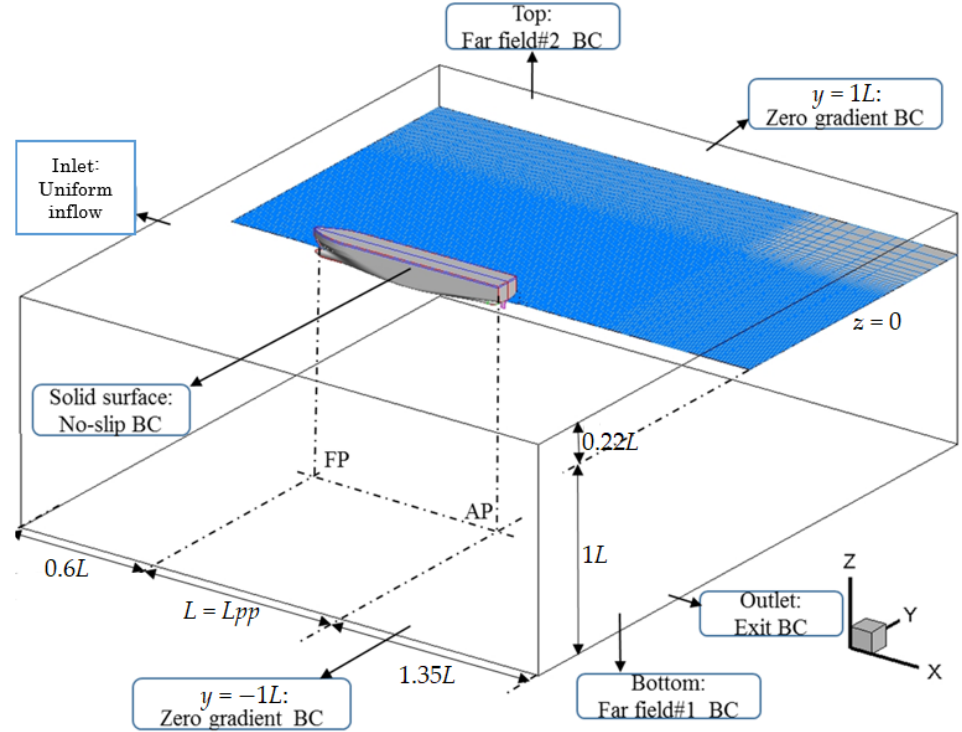
Figure 5. Computational domain and boundary conditions for propeller behind hull condition [41].